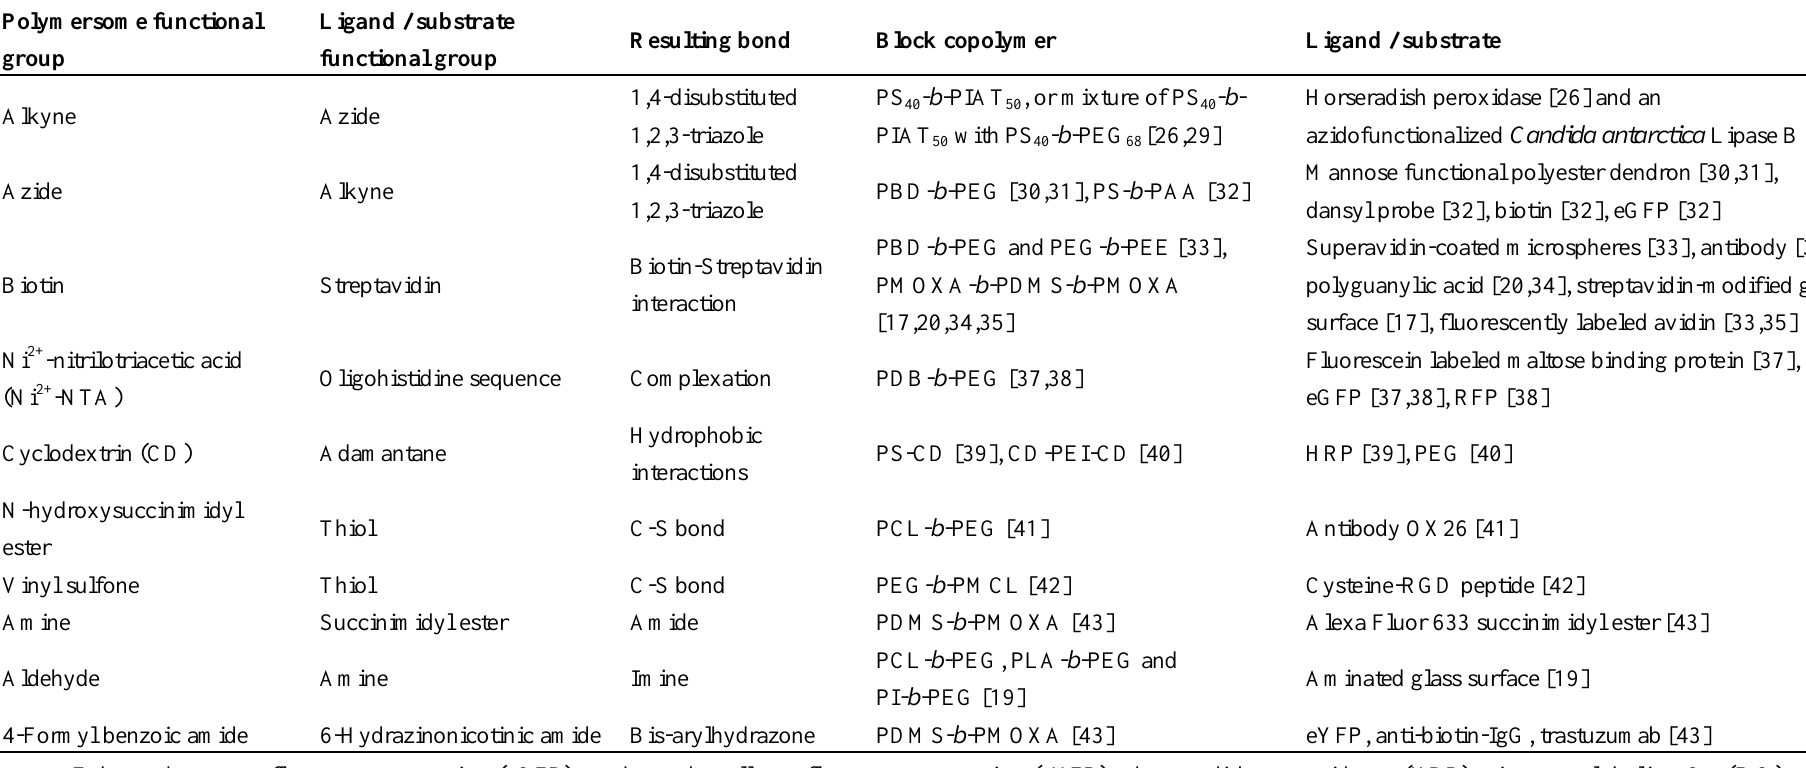
Table 1. Overview of methods used to conjugate ligands and other functional entities to preformed block copolymer vesicles. Polymersome